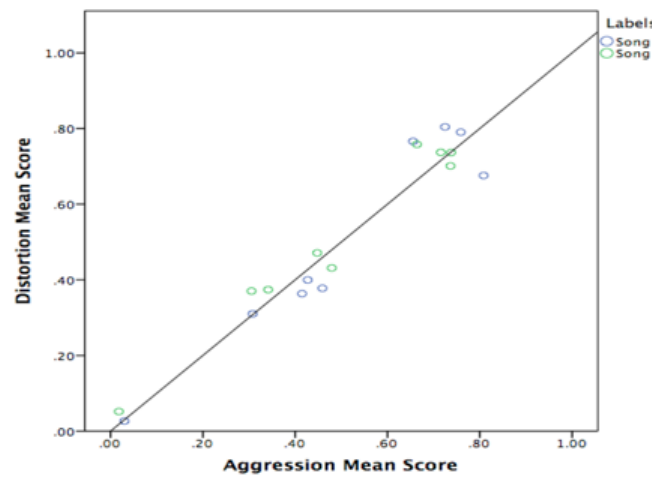
Figure 5. Scatter plot for aggression and distortion mean scores.